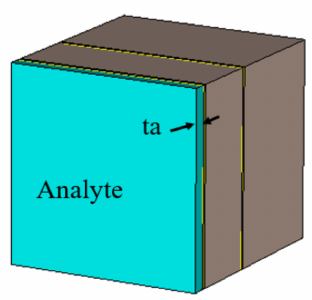
Figure 11. Experimental setup for sensitivity estimation.